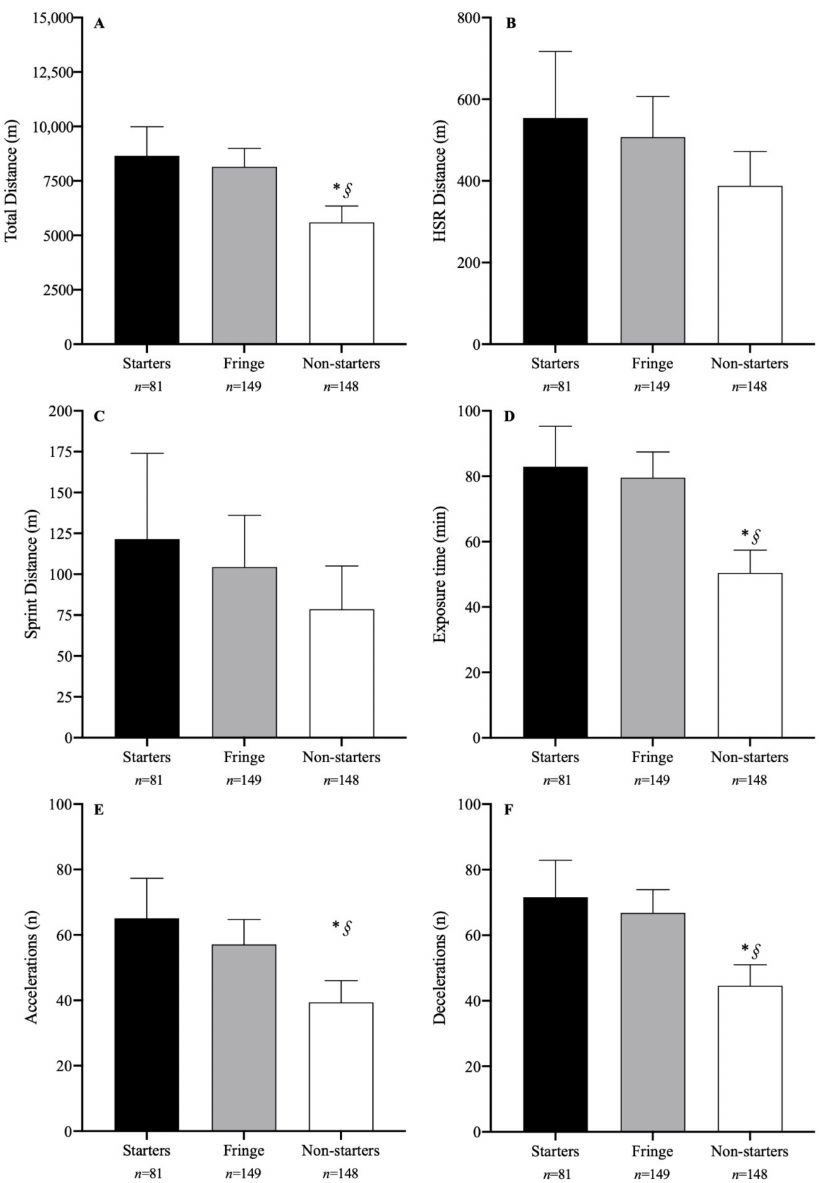
Figure 1. Mean ± 95% IC estimates for total distance ( A ), HSR distance ( B ), sprint distance ( C ), exposure time ( D ), and number of accelerations ( E ) and decelerations ( F ) throughout the whole competitive season. * significantly different from starters; § significantly different from fringe. The number of observations ( n ) for each condition is presented below the respective group. Abbreviations: HSR—high-speed